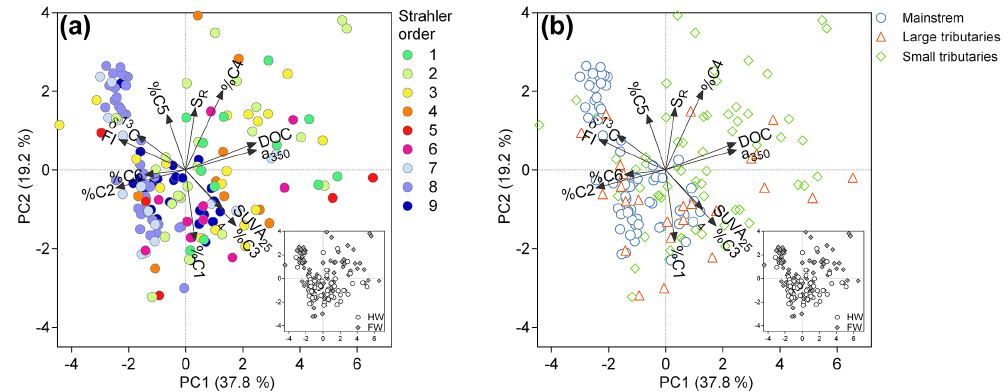
Figure 6. Graphical representation of PCA results, including a loadings plot for the input variables and a scores plot for stations based on (a) their Strahler stream order or (b) sampling location. PCA results based on the hydrological period is included in each